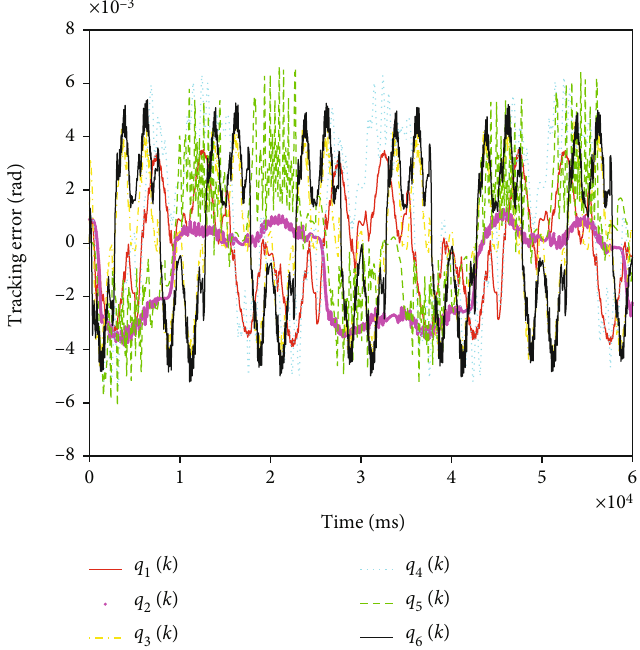
Figure 8: Tracking error of each robotic joint controlled by cascaded PD